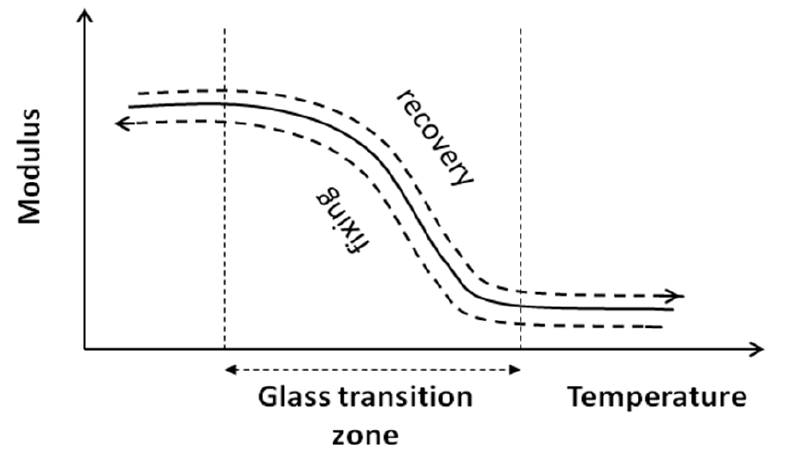
Figure 10. Variation of modulus versus temperature (fixing and